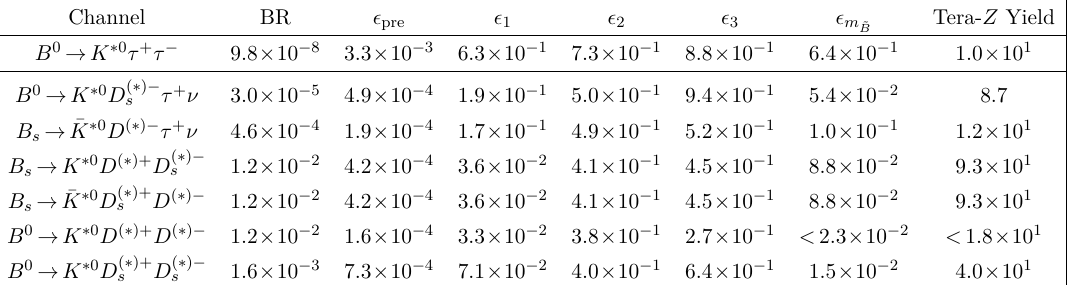
Table 11 . Detailed cut flows and Tera- Z yields for the B 0 → K ∗ 0 τ + τ − measurement. (cid:15) denotes the efficiency for each cut defined in the text.